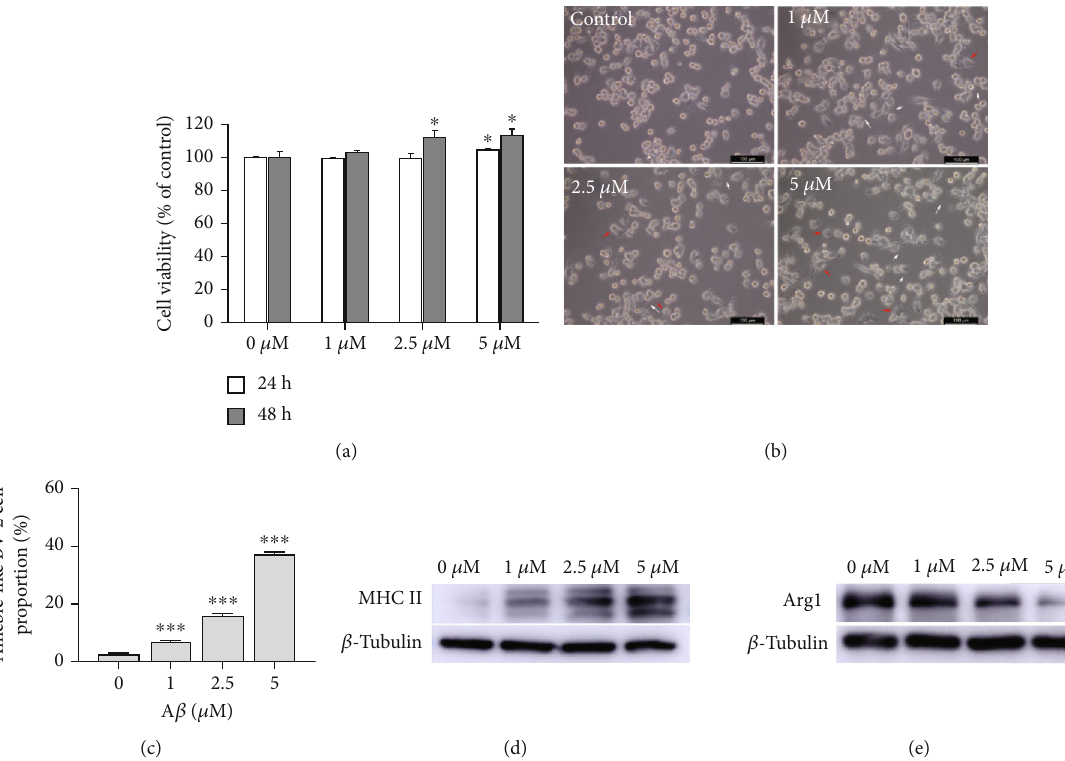
Figure 1: A β induced BV-2 cell activation. (a) A β promotes BV-2 cell proliferation. The proliferation of BV-2 cells increased with the 1-42 1-42 increase of A β treatment time and concentration. Both 24 h and 48 h treatment of A β could induce the proliferation of BV-2 cells. Only 1-42 1-42 5 μ M A β induced BV-2 cell proliferation signi fi cantly at the treatment time of 24h, while both 2.5 μ M and 5 μ M could promote BV-2 cell 1-42 proliferation at the treatment time of 48h. (b) A β induced morphological changes in BV-2 cells. Under the action of A β , BV-2 cells 1-42 1-42 presented shortening of the processes and swelling of the soma. (c) Quantitative statistics of the increase of ameba-like cell proportion under treatment of A β . (d, e) Under the treatment of A β , MHC II protein levels were upregulated while Arg1 was downregulated 1-42 1-42 with the increase of concentration of A β . ∗ P < 0 : 05 vs. control; ∗∗∗ P < 0 : 001 vs. control. 1-42